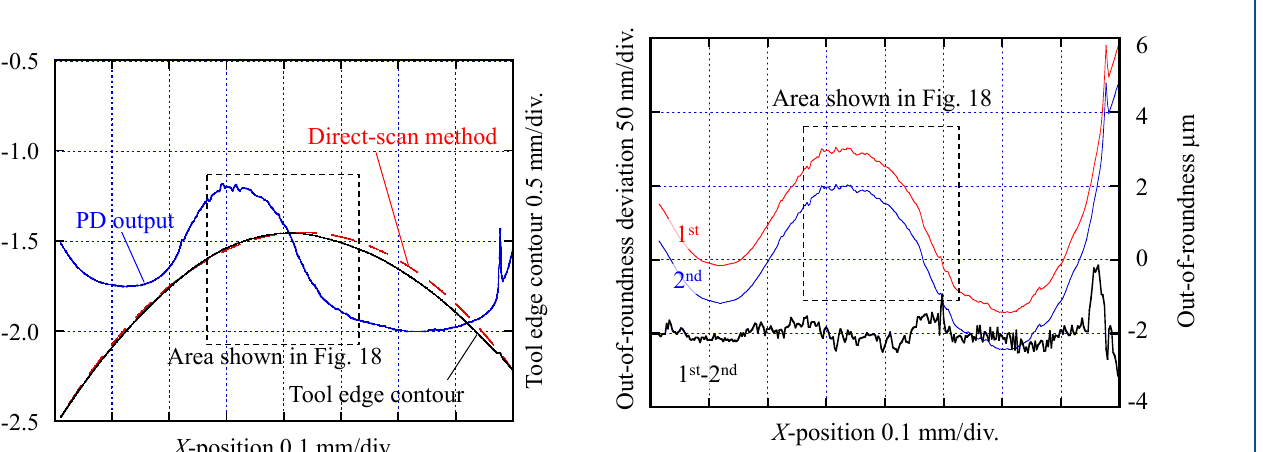
Figure 14. Deviation of the out-of-roundness measured by the raster-scan method.